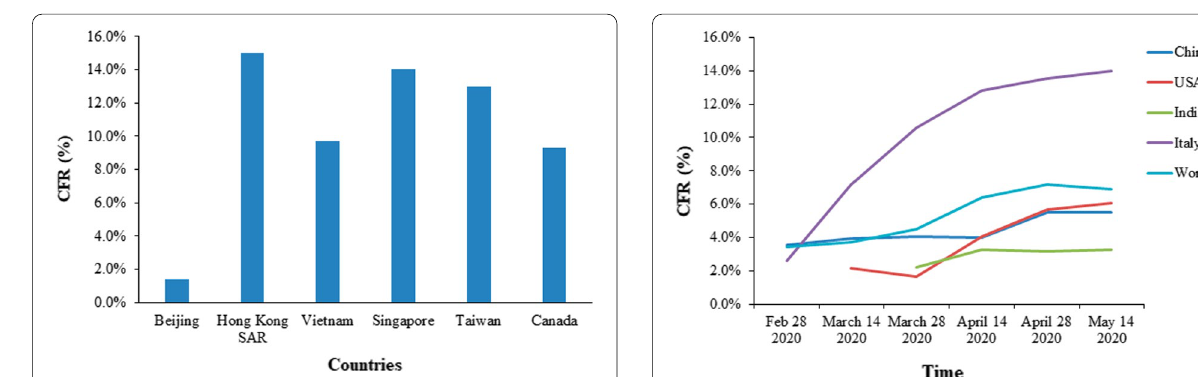
Fig. 5 Crude case fatality ratios area-wise (According to WHO consensus)